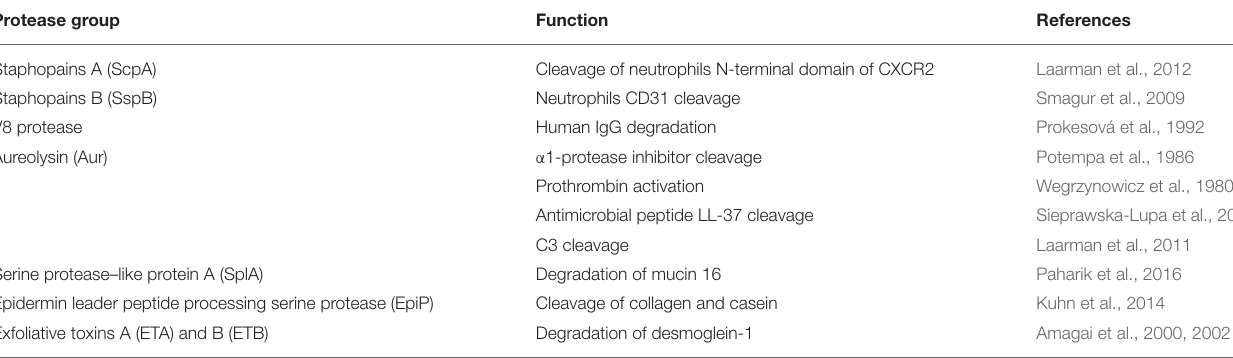
TABLE 1 | The main S. aureus secreted